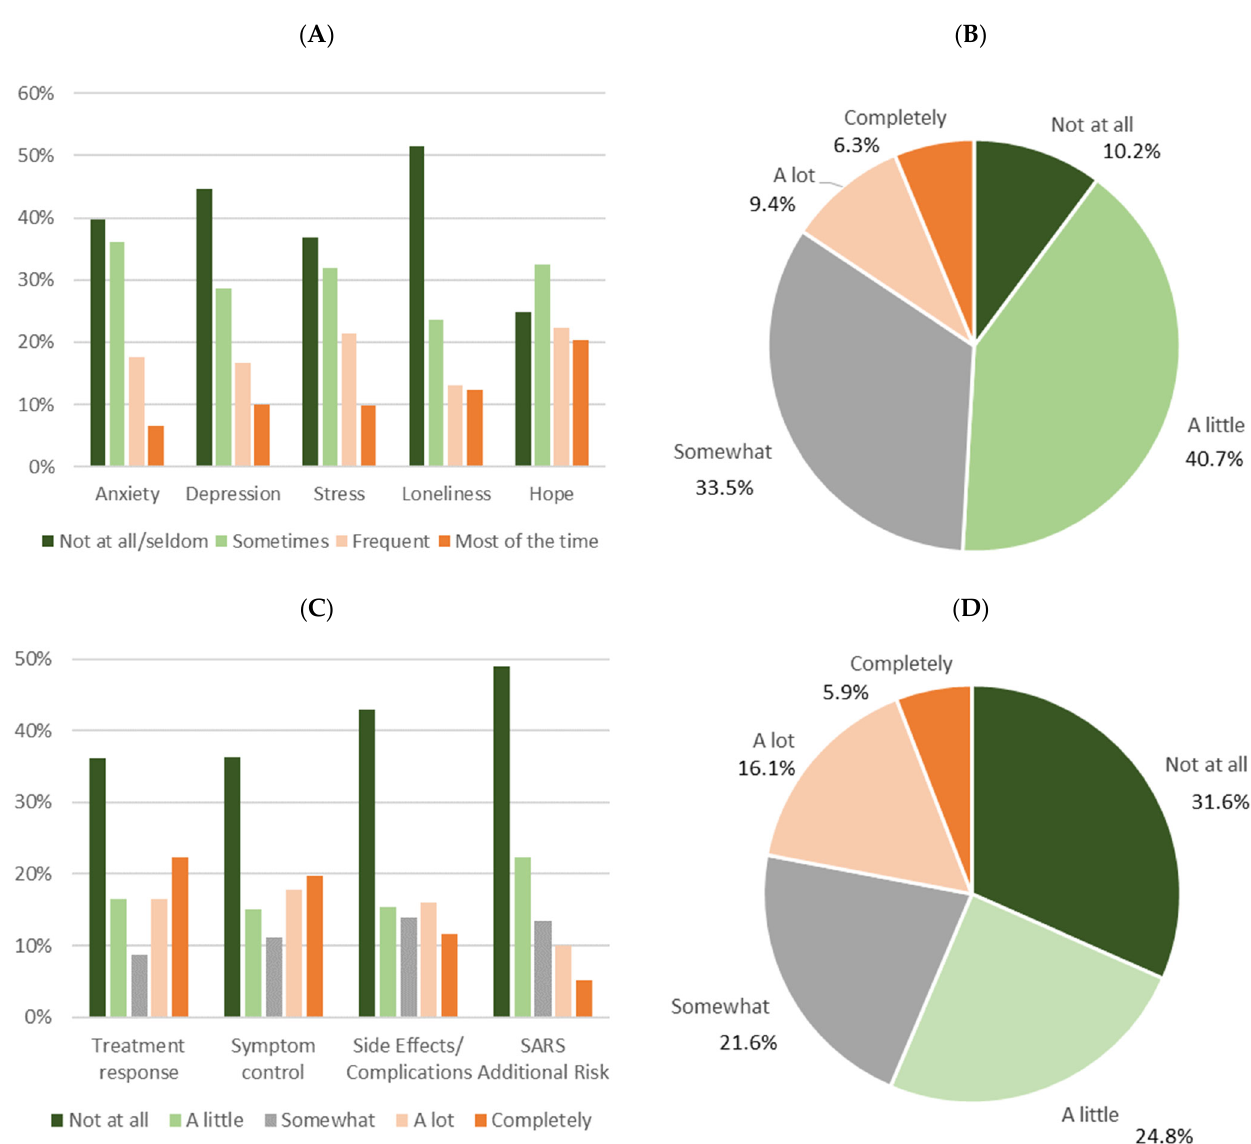
Figure 2. ( A ) Perception of anxiety, depression, stress, loneliness and hope within two weeks before questionnaire; ( B ) reflection of own pandemic risk during data-capture period; ( C ) modification requirement for treatment and patients’ criteria for treatment decisions; ( D ) burden due to additional risk for treatment by COVID ‐ 19 (Percentages of all respondents).